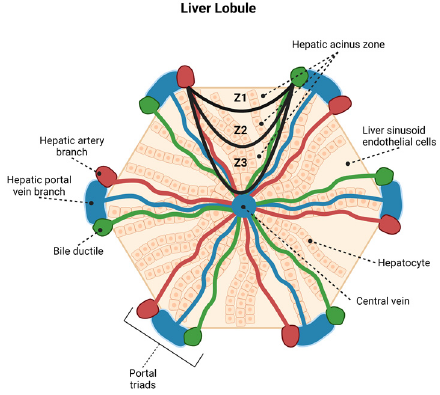
Figure 1. Illustrative diagram demonstrating the hepatic lobule constituted by acini and the division scheme between zone 1 (Z1), zone 2 (Z2), and zone 3 (Z3) located around the portal tract (PT) (Z1), midzonal area (Z2), and around the central lobular vein (Z3). (This figure was created with biorender.com )